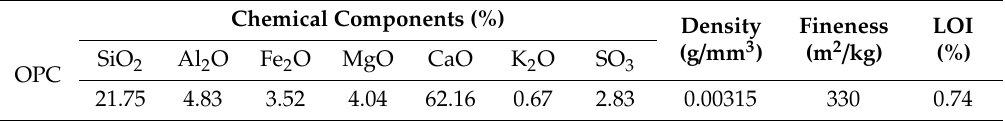
Table 1. Properties of ordinary Portland cement (OPC).